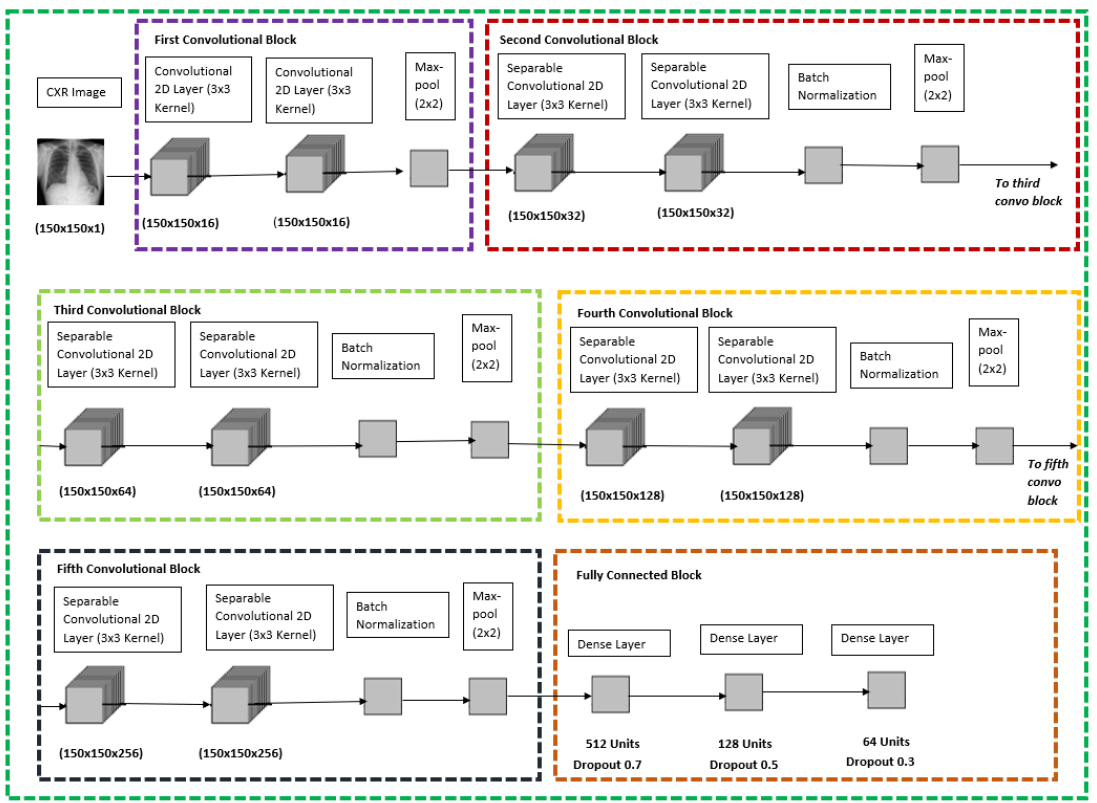
Figure 2. Architecture for CXR Model.